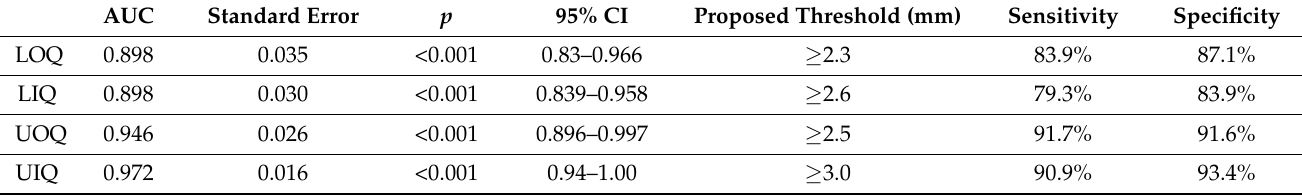
Table 9. Ultrasound AUC statistics plus proposed reference ranges, sensitivity and specificity.